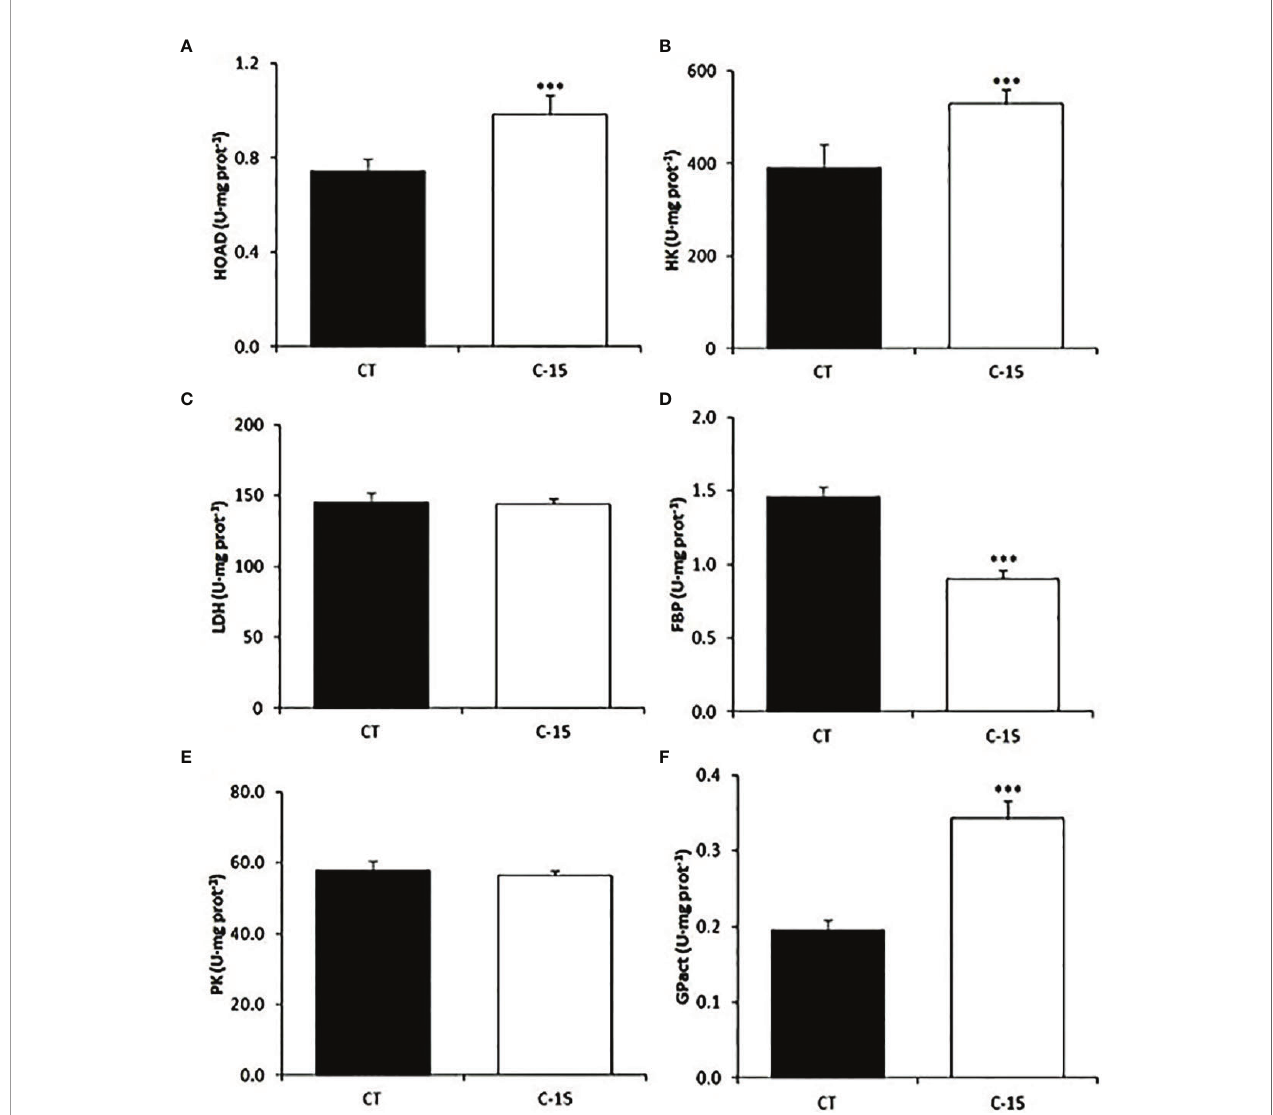
FIGURE 4 | Speci fi c activity (U mg protein − 1 as mean ± SEM) of metabolic enzymes in the liver of juvenile (C) labrosus fed control (CT) and C-15 diets during 90 days. Asterisks denote signi fi cant differences at p < 0.001 (***). (A) HOAD, 3-hydroxyacyl-CoA dehydrogenase; (B) HK, hexokinase; (C) LDH, lactate dehydrogenase; (D) FBP, fructose 1,6-bisphosphatase; (E) PK, pyruvate kinase; (F) GPase, glycogen phosphorylase